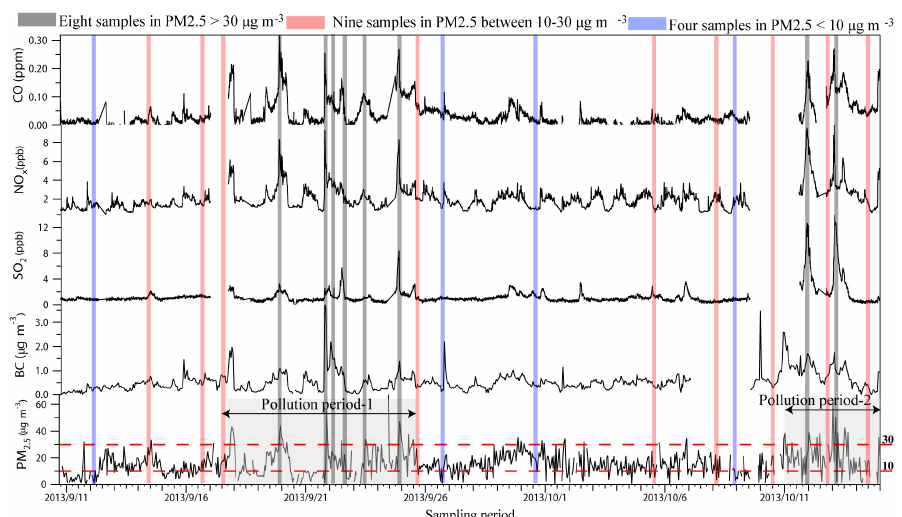
Figure 2. Time-series concentration of air pollutants (i.e., CO, NO x , SO 2 , BC, and PM 2 . 5 ) during 11 September–15 October 2013. The sampling time is marked by grey (PM 2 . 5 ≥ 30µgm − 3 ) , pink (PM 2 . 5 between 10 and 30µgm − 3 ) , and blue columns (PM 2 . 5 < 10µgm − 3 ) .